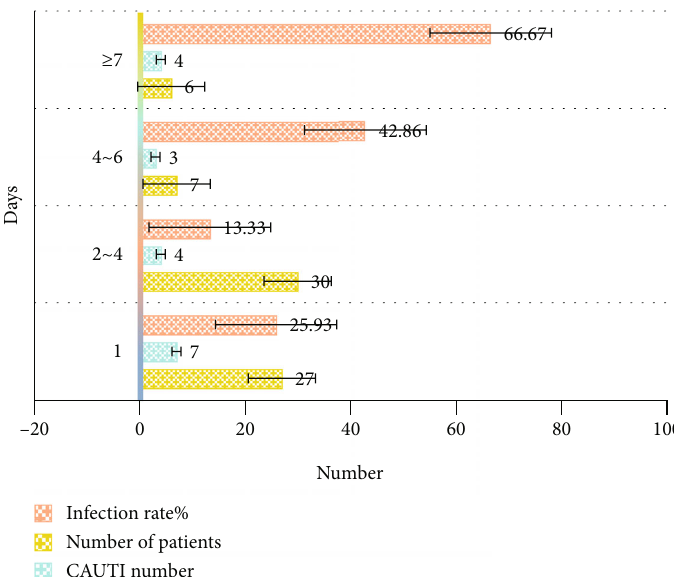
Figure 2: In fl uence of changing time of urine collection bag on CAUIT. Table 3: The e ff ect of catheter replacement time on CAUIT. Catheter